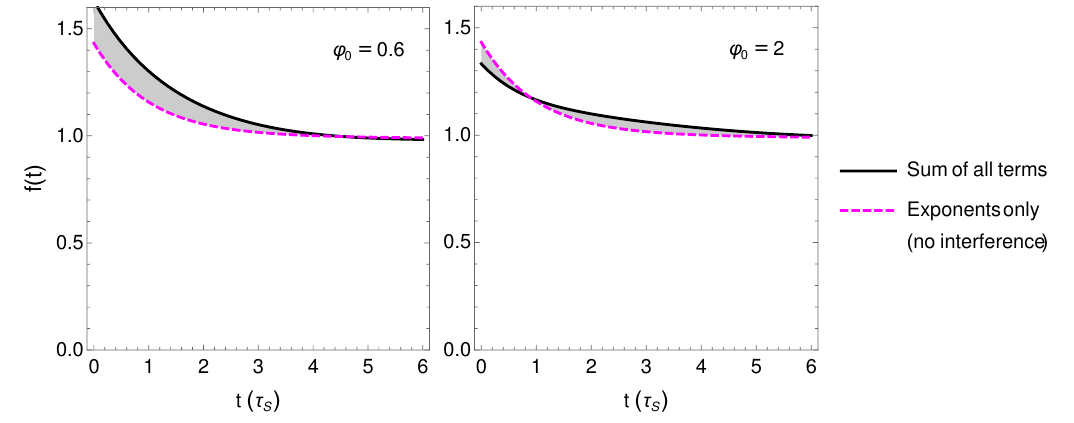
Figure 2 . The expected approximate time dependence within the SM, using the coefficients of ∗ A CP-even eq. (6.1), for two values of ϕ 0 = arg( A CP-odd ) . The difference between the dashed magenta 0 0 curve and the solid black one is a measure of interference